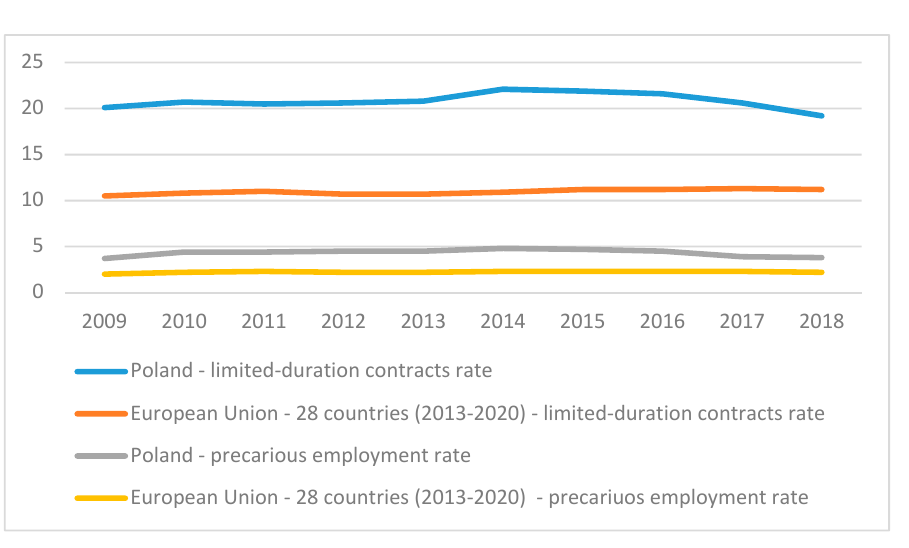
Table 1. Number of people employed in Poland based on non-standard forms of employment based on [63]. Form of Employment